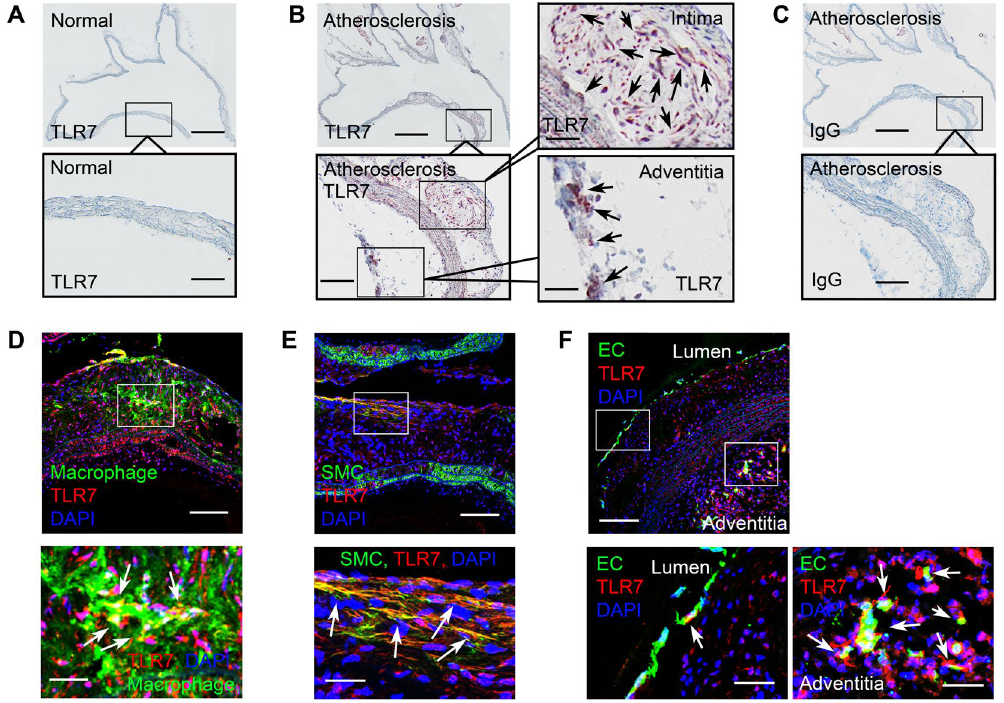
Figure 1. TLR7 expression in mouse atherosclerotic lesions. ( A) Rabbit-anti-mouse TLR7 monoclonal antibody immunostaining of a normal mouse aortic arch. Scale: 1 mm, inset scale: 200 µ m. ( B ) Rabbit- anti-mouse TLR7 monoclonal antibody immunostaining of an aortic arch from an Apoe − / − mouse with atherosclerosis showed TLR7 expression in intima and adventitia. Scale: 1 mm, inset scales: 200 and 68 µ m. Arrows indicate TLR7-positive cells. ( C ) Rabbit IgG isotype immunostaining of a parallel aortic arch from an Apoe − / − mouse with atherosclerosis. Scale: 1 mm, inset scale: 200 µ m. ( D–F ) Immunofluorescent double staining of mouse aortic arch atherosclerotic lesions with antibodies against TLR7 and cell type markers (Mac- 2, α -actin, and CD31) for macrophage, SMC, and EC from both the lumen and adventitia microvessels. Scale: 100 µ m, inset scale: 25 µ m. Arrows in the insets indicate TLR7-positive macrophages ( D ), SMCs ( E ), and ECs in lumen and adventitia ( F